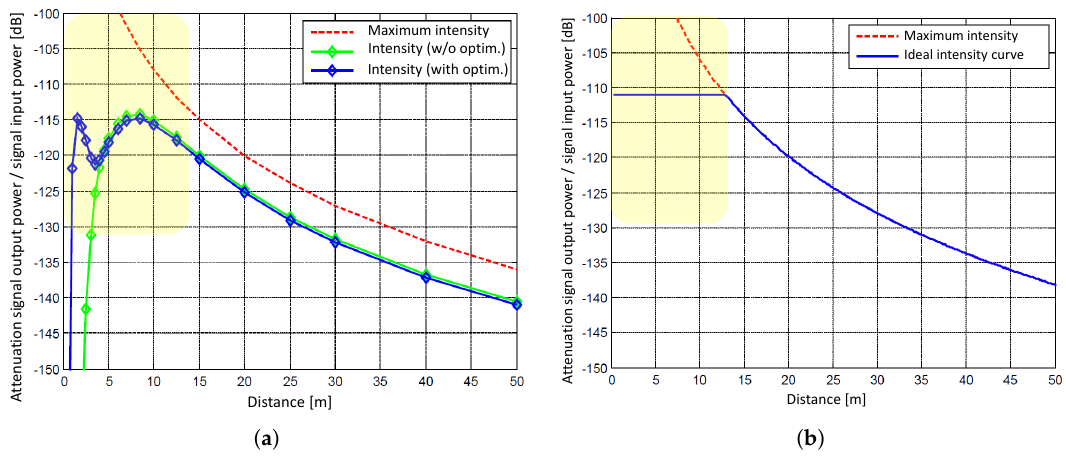
Figure 2. ( a ) Simulation of the optical receiving unit of the Z + F Profiler 9012/9012A (without/with close range optimization) as a function of the distance between laser scanner and object. ( b ) Simulation of an ideal intensity curve (by courtesy of Zoller & Fröhlich GmbH, Wangen im Allgäu,